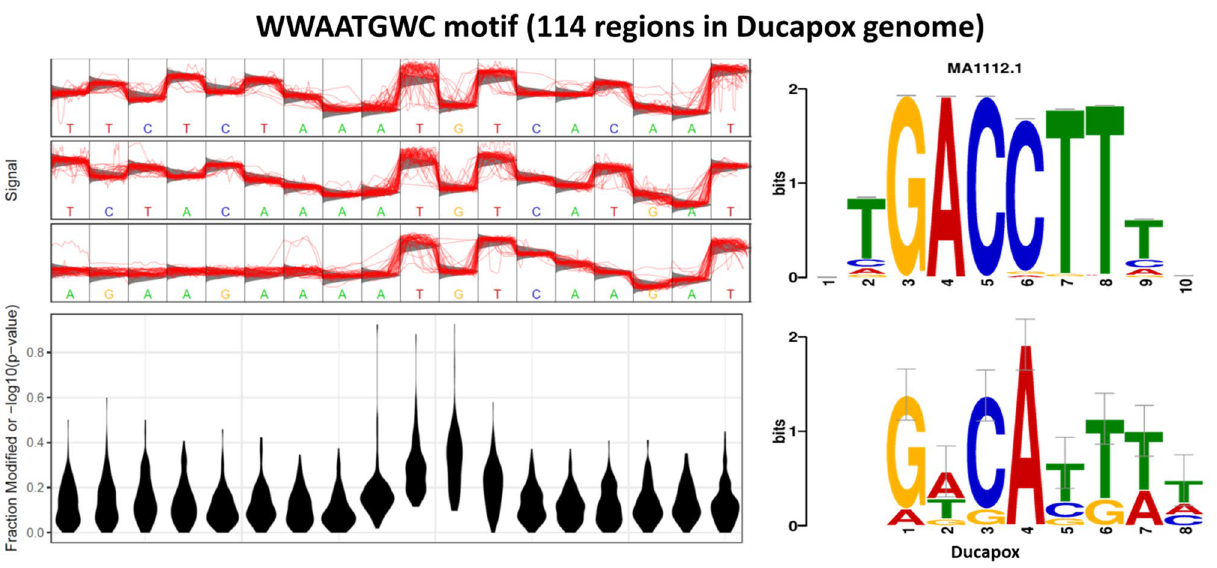
Figure 6. Statistical plot and sequence logo of the WWA ATG WC motif. The statistical plot is based on 77 regions within the genome that contain the motif sequence. Signal fluctuation away from the canonical model can be seen around the central TGT